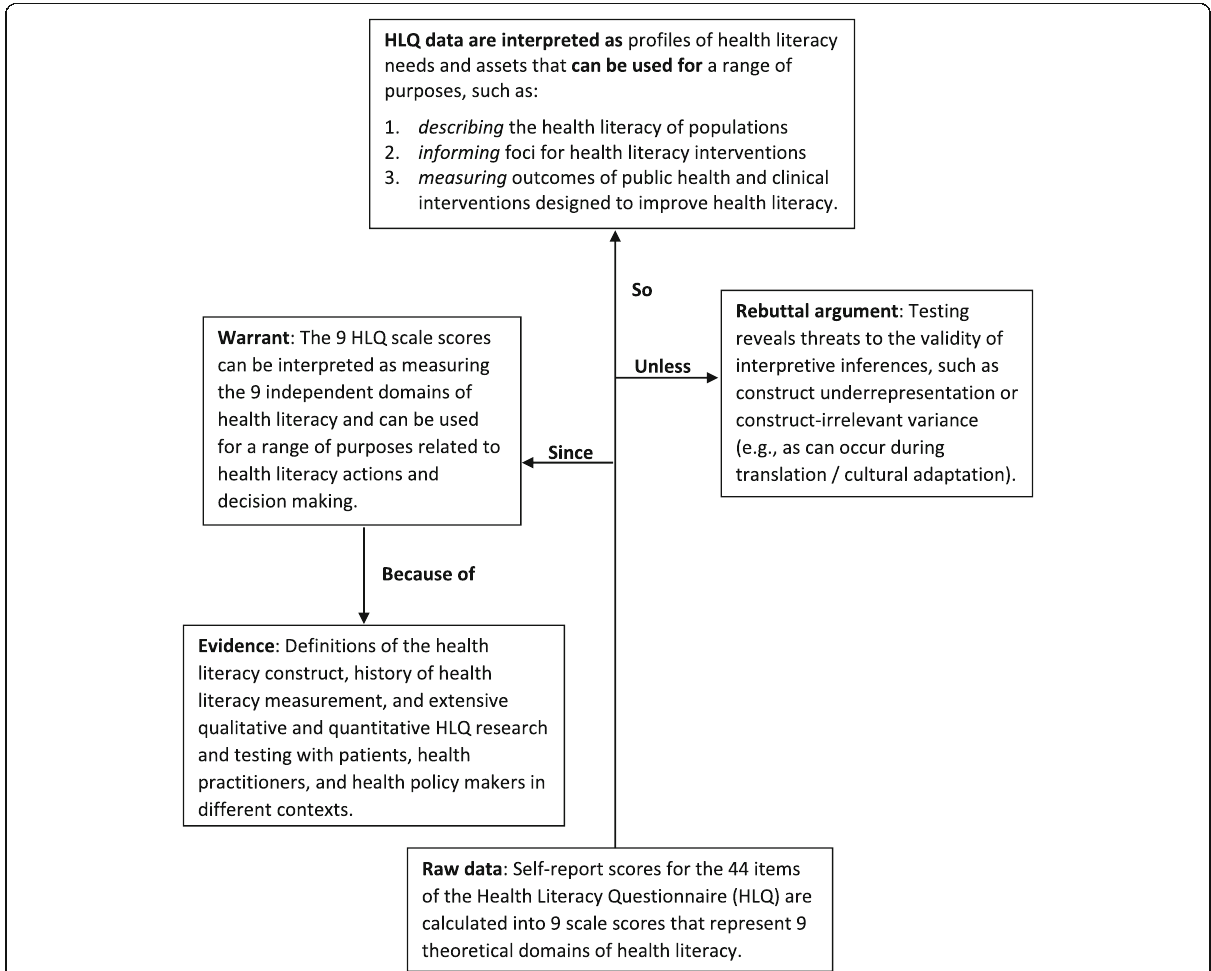
Fig. 1 A general interpretive argument for the Health Literacy